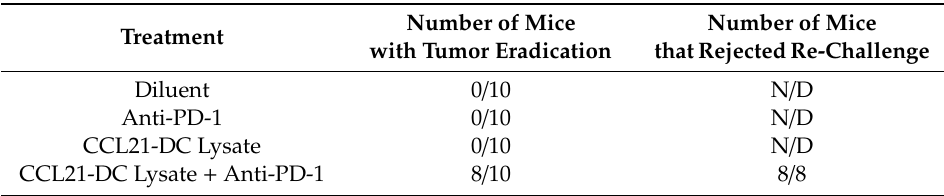
Table 1. Anti-PD-1 blockade plus CCL21-DC lysate vaccine eradicated established tumors. Number of Mice Number of Mice Treatment with Tumor Eradication that Rejected Re-Challenge Diluent 0 / 10 N / D Anti-PD-1 0 / 10 N / D CCL21-DC Lysate 0 / 10 N / D CCL21-DC Lysate + Anti-PD-1 8 / 10 8 / 8